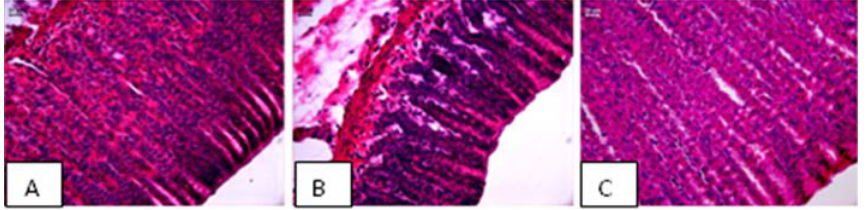
Gastric mucosal layer of rats stained with HE showing (A) normal epithelium from control rats; (B) damaged epithelium from Tween treatment and (C) repaired epithelium after AcF